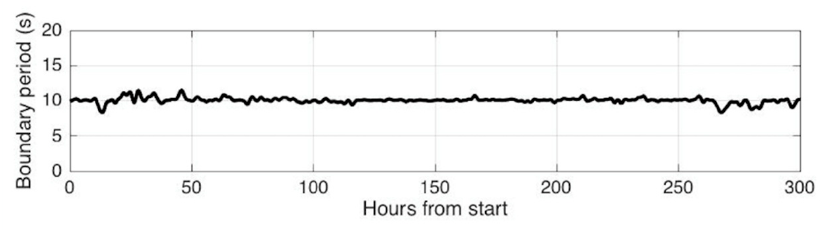
Figure 4. The boundary period plotted vs. time. Start time: 12:00 PM, 6 January 2021.